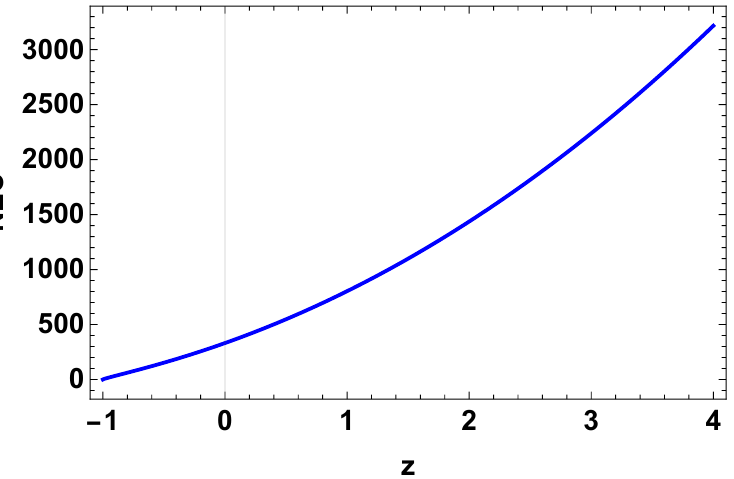
Figure 7. Behavior of the NEC vs.